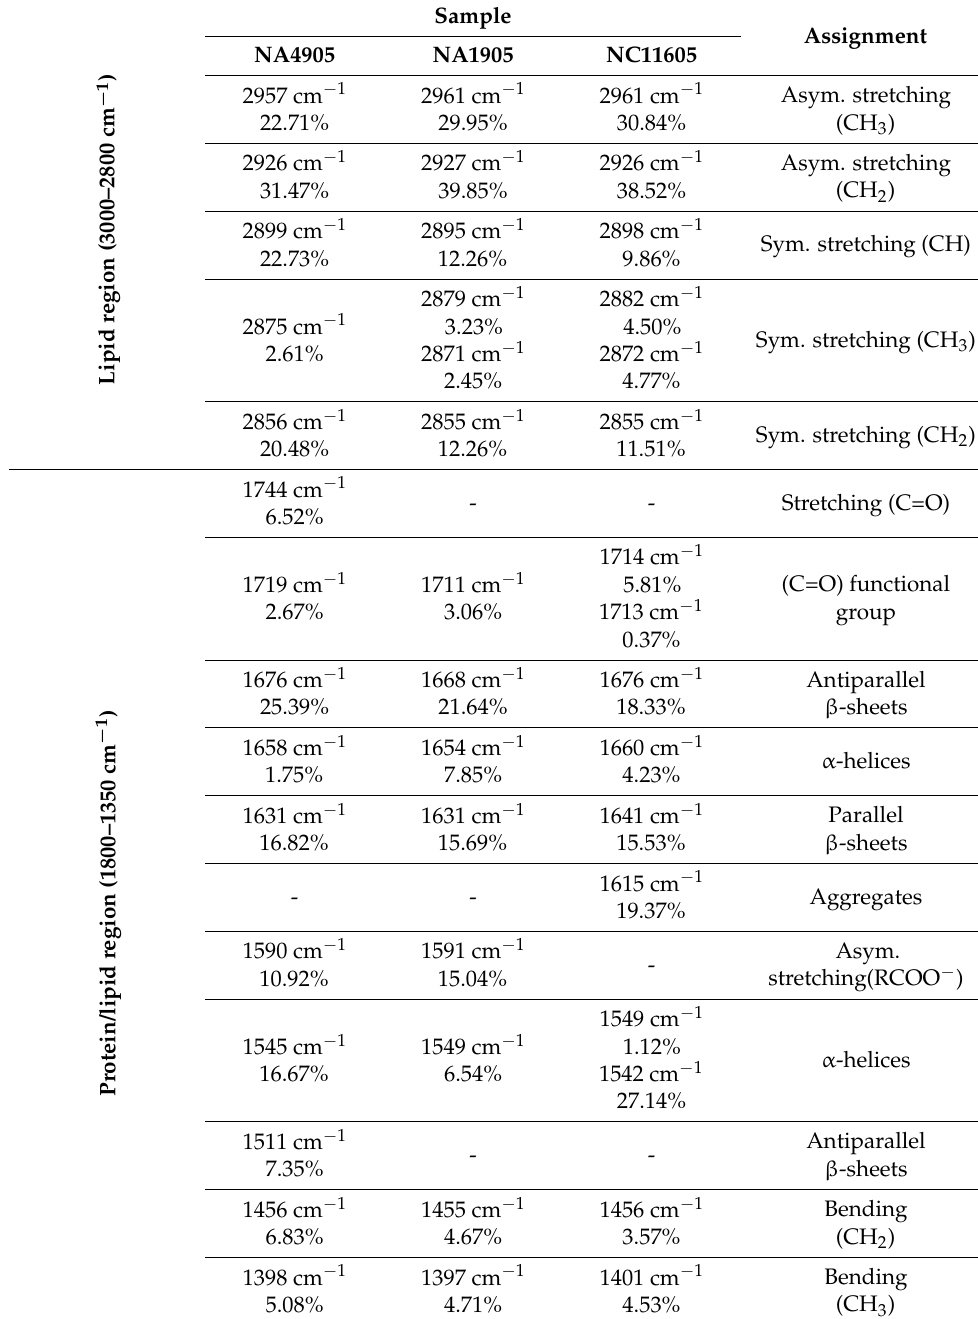
Table 2. Collective data showing the results of deconvolution presented in Figure